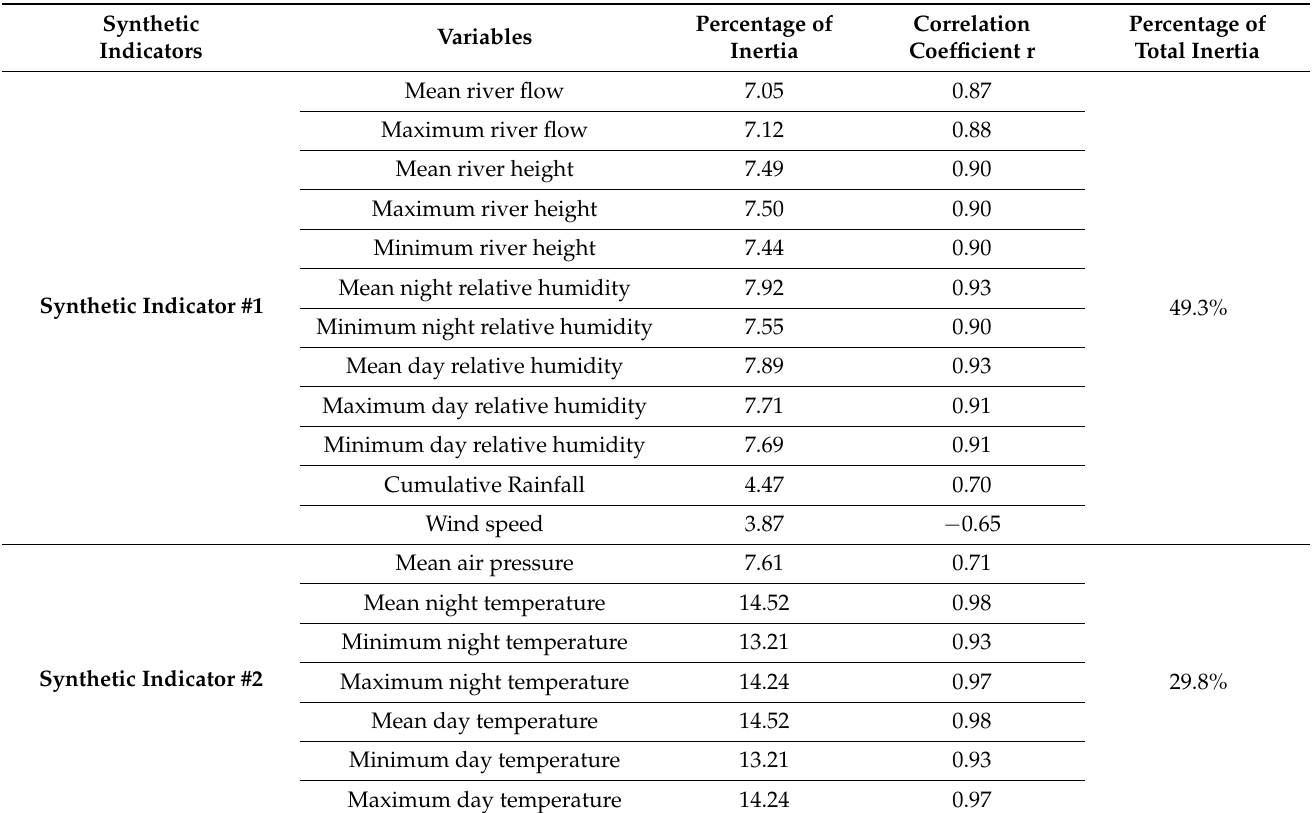
Table 1. Correlation of the main synthetic indicators with malaria